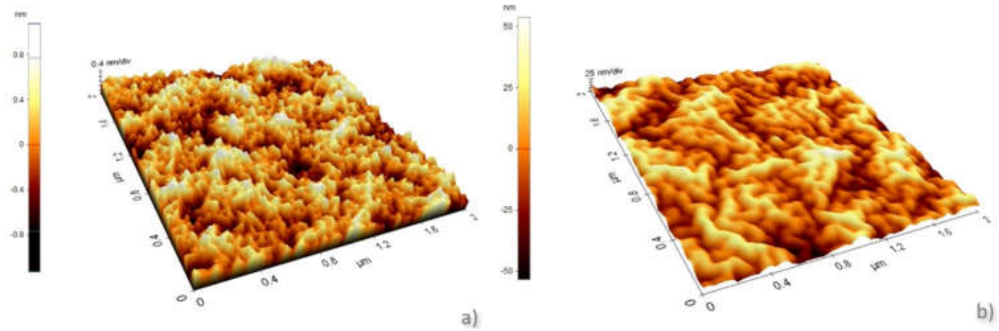
Figure 2. ( a ) AFM image of PMMA layer deposited on quartz; ( b ) AFM image of a gold layer deposited onto the PMMA/quartz surface in vacuum conditions (<10 − 5 Torr). The gold layer was deposited using 2200 pulses.